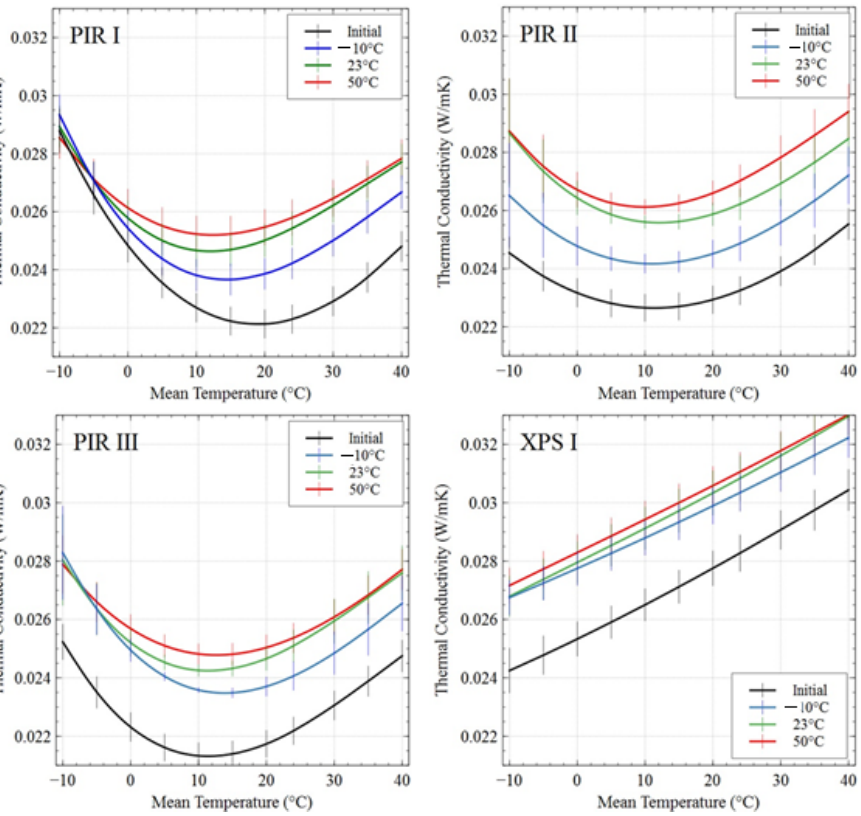
Figure 4. Thermal conductivity as a function of mean temperature for specimens conditioned at − 10, 23, and 50 ◦ C for the equivalent of 5 years in comparison to initial